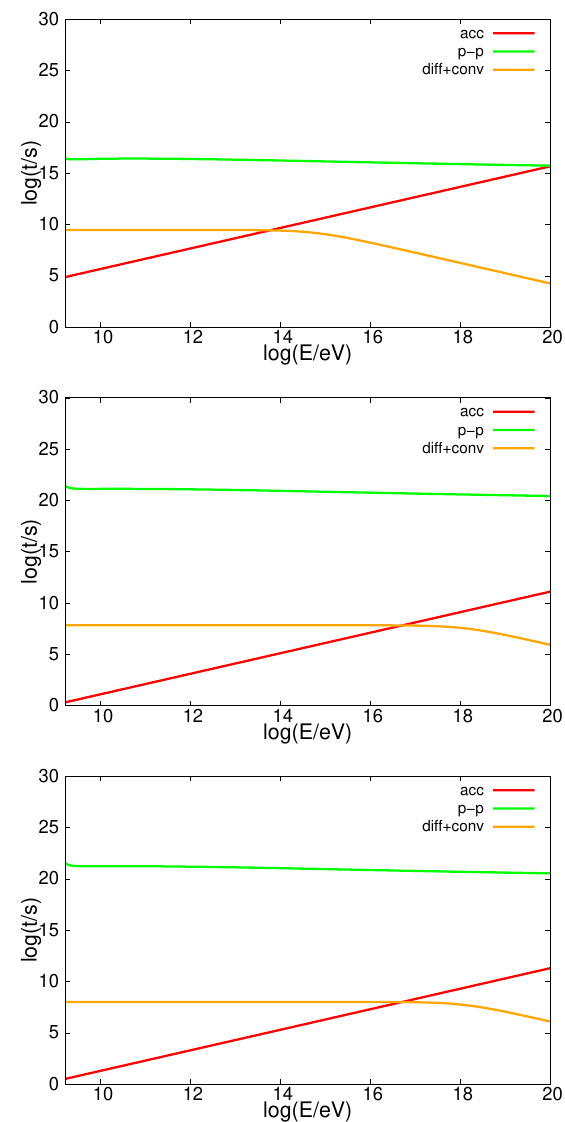
Figure 6. These plots show the acceleration, cooling by proton- proton inelastic collisions, and escape timescales for a shock into the wind of a star located at z = 100 pc (top panel), for shocks in the jet of a system at z = 150 pc (middle panel), and at z = 200 pc (bottom panel). The maximum energies obtained are 10 14 eV, 5 × 10 16 eV, and 6 × 10 16 eV,